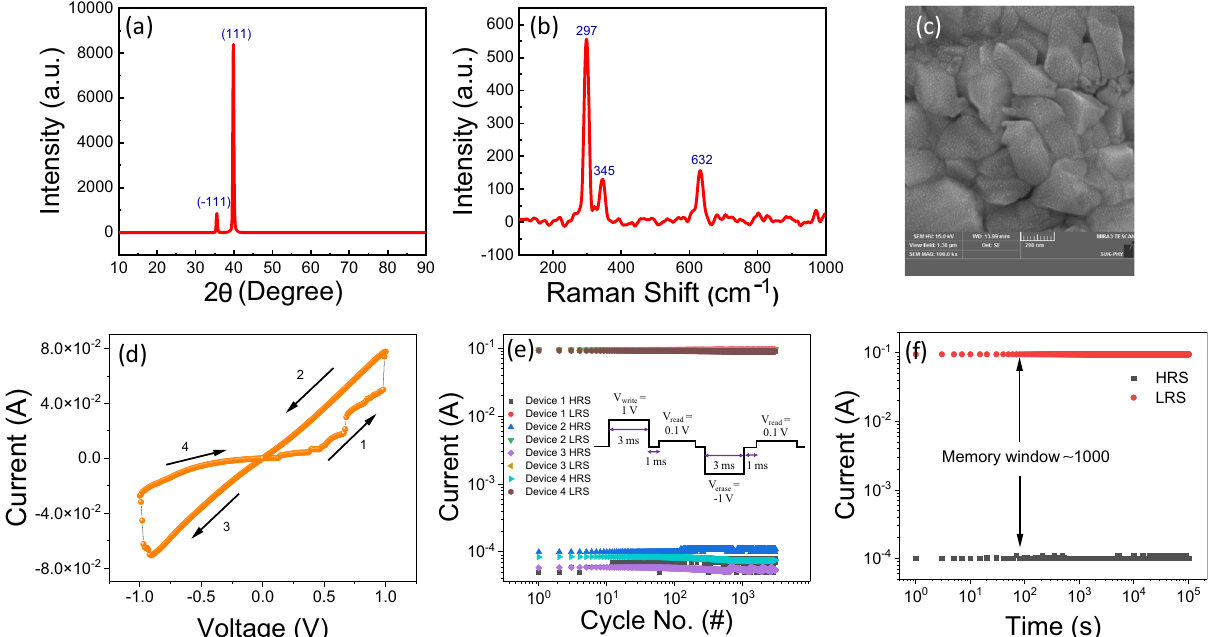
Figure 8. ( a ) XRD pattern, ( b ) Raman spectrum, and ( c ) FESEM image of fabricated CuO thin film. ( d ) I–V, ( e ) endurance, and ( f ) retention properties of CuO RS